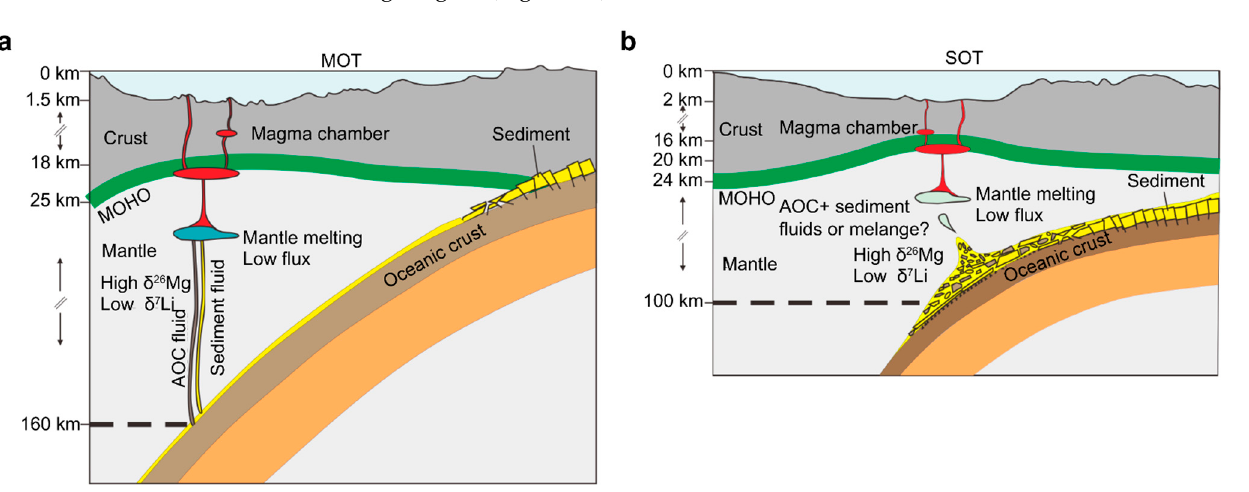
Figure 10. Schematic diagram showing the different contributions of subduction components to the ( a ) MOT and ( b ) SOT.